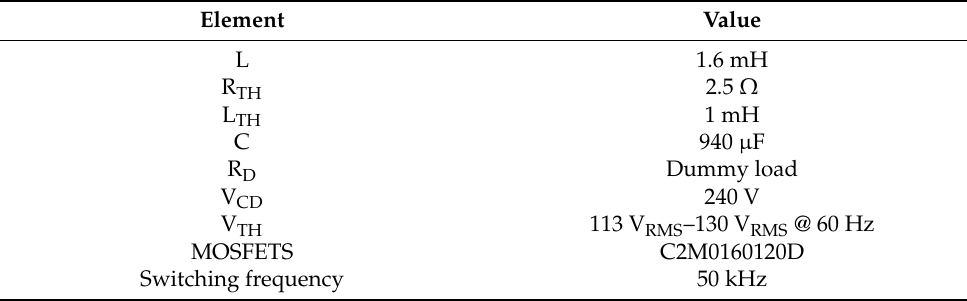
Table 1. Specifications of the prototype.